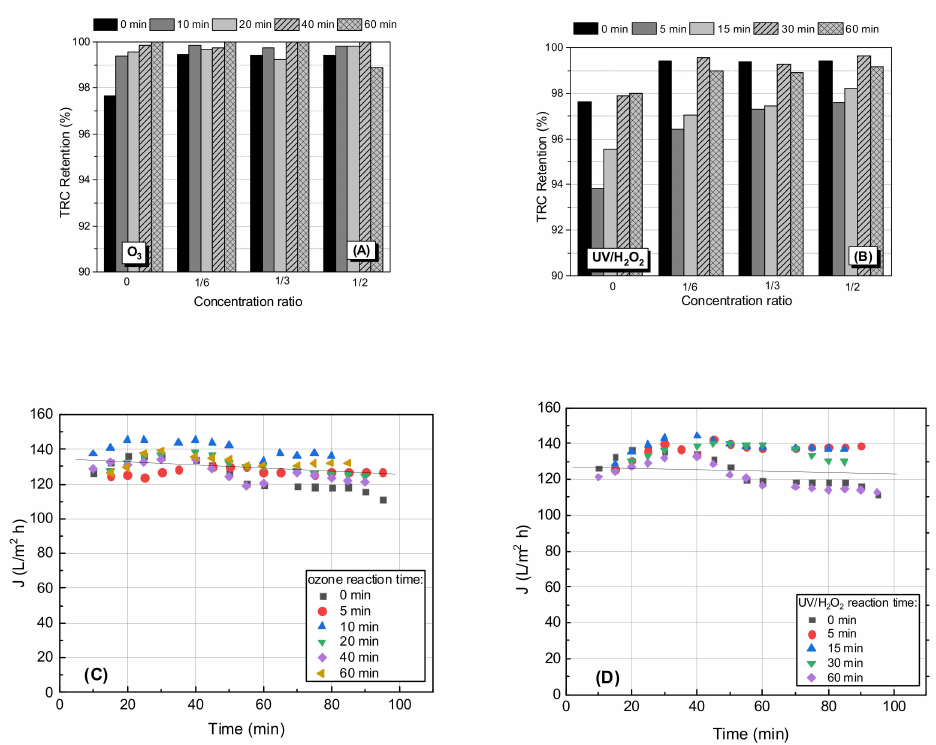
Figure 4. ( A ) TRC retention for different reaction time of ozonation; ( B ) TRC retention for different reaction time of UV/H 2 O 2 ; ( C ) filtrate flux (J) for nanofiltration of ozonated TRC solution; ( D ) filtrate flux for nanofiltration of UV/H 2 O 2 —oxidized TRC solution; membrane HL; pressure 1.0 MPa; temp. 30 ◦